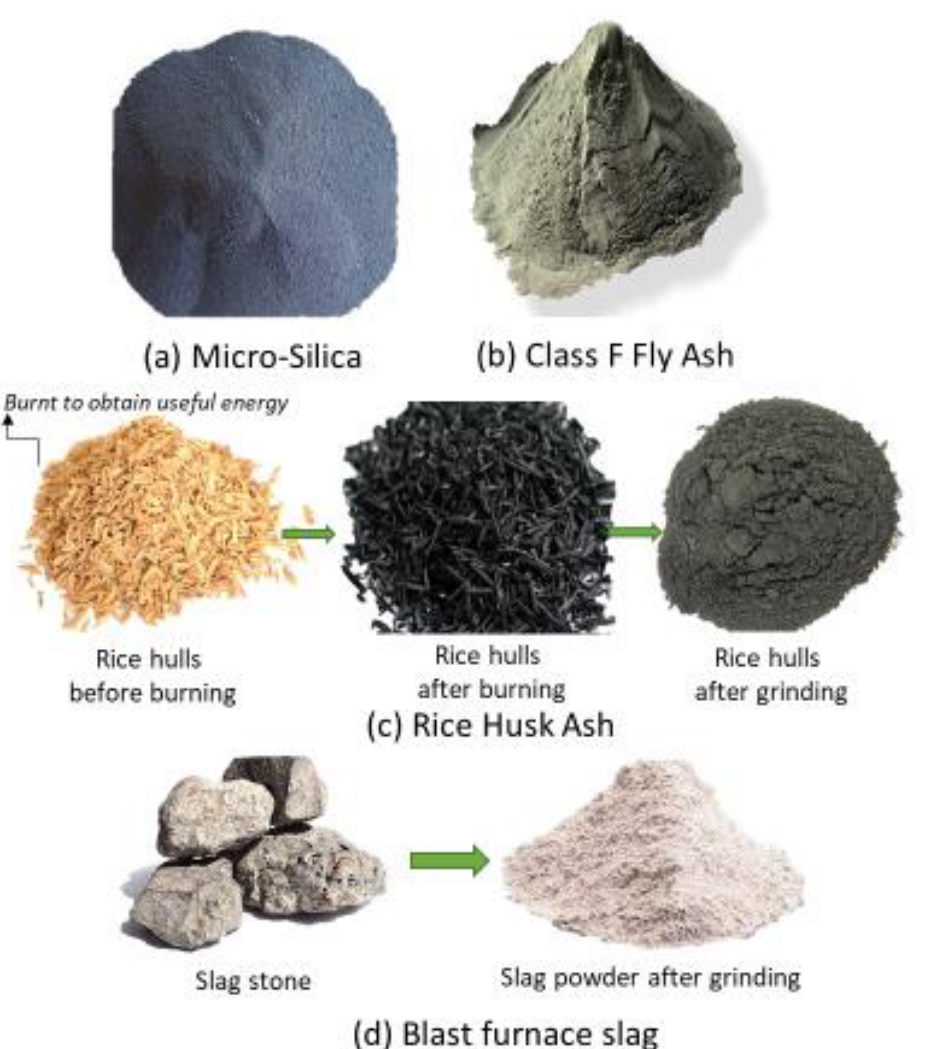
Figure 1. Physical appearances of ( a ) MS, ( b ) FA, ( c ) RHA, and ( d ) BFS.